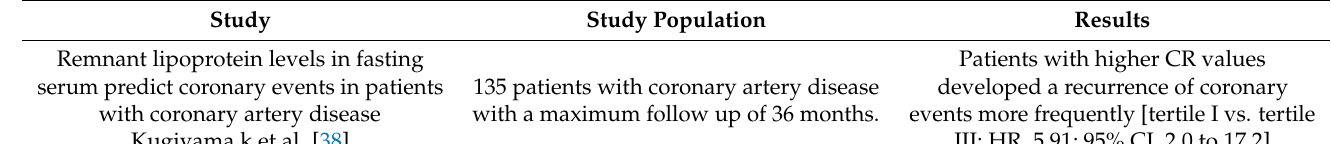
Table 1. Main epidemiological studies on cholesterol remnants (CR) and cardiovascular